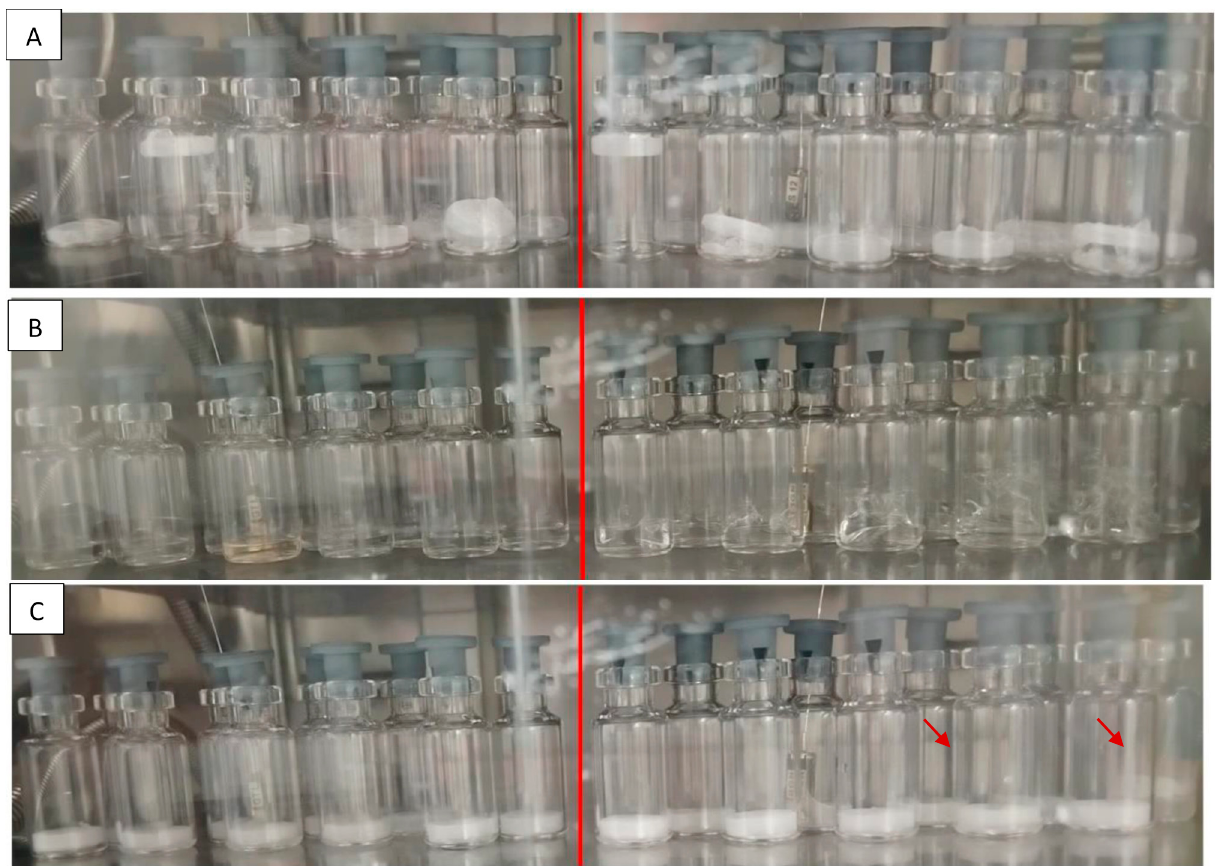
Figure 2. Two groups of TopLyo vials were filled with the DW ( A ) or DW + TW80 ( B , C ) formulations. ( A ) Defects due to boiling were observed in both degassed ( left ) and non-degassed ( right ) DW vials. ( B ) In the non-degassed DW + TW80 group ( right ), bubbling phenomena were observed while inducing nucleation. ( C ) The morphology of the DW + TW80 frozen product was acceptable when degassing was performed ( left ), whereas small defects due to bubbling (as indicated by arrows) could be observed in the non-degassed samples ( right ). All these pictures were taken immediately after nucleation.